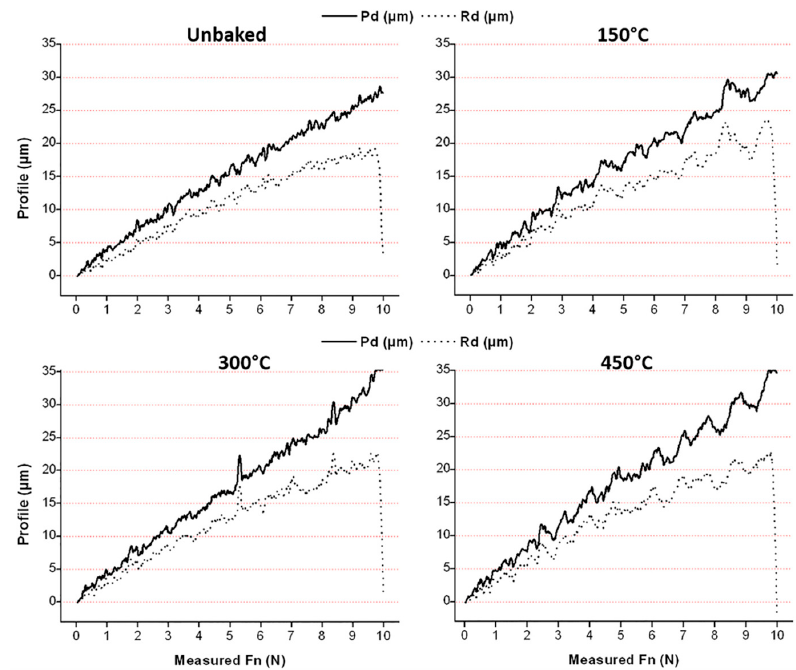
Figure 9. Penetration depth and residual depth of the scratch test.